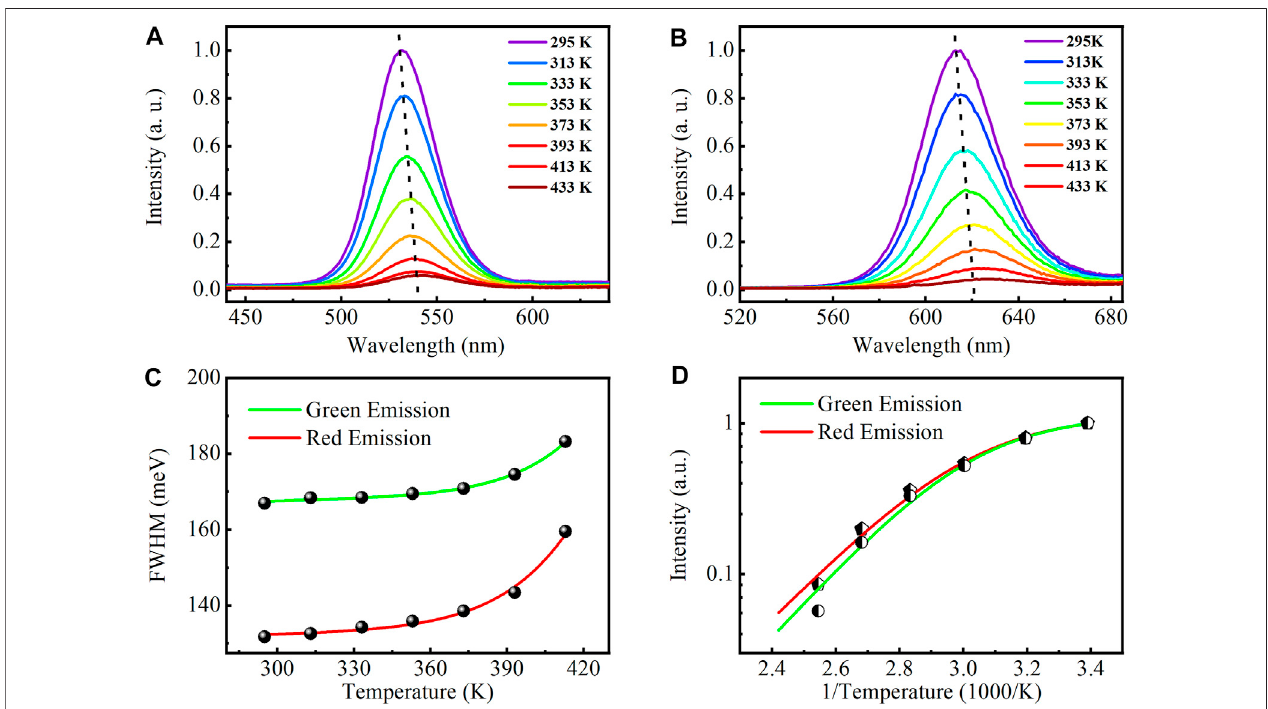
FIGURE3| PhotoluminescencespectraoftheCdZnSeS/ZnSeSQDsatvarioustemperatures(T=295K – 433 K). (A) CdZnSeS/ZnSeSQDsatgreenemission. (B) CdZnSeS/ZnSeS QDs at red emission. Temperature-dependent change of (C) FWHM and (D) intensity. QDs, quantum dots; FWHM, full width at half maximum.